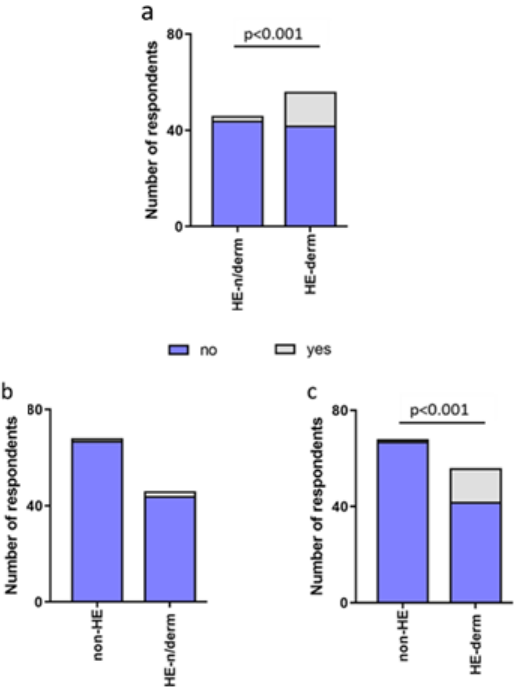
Figure 14. Comparison of the frequency of medical appointments during pandemic in study groups: ( a ) HE-n/derm vs. HE-derm; ( b ) non-HE vs. HE-n/derm; ( c ) non-HE vs. HE-derm.